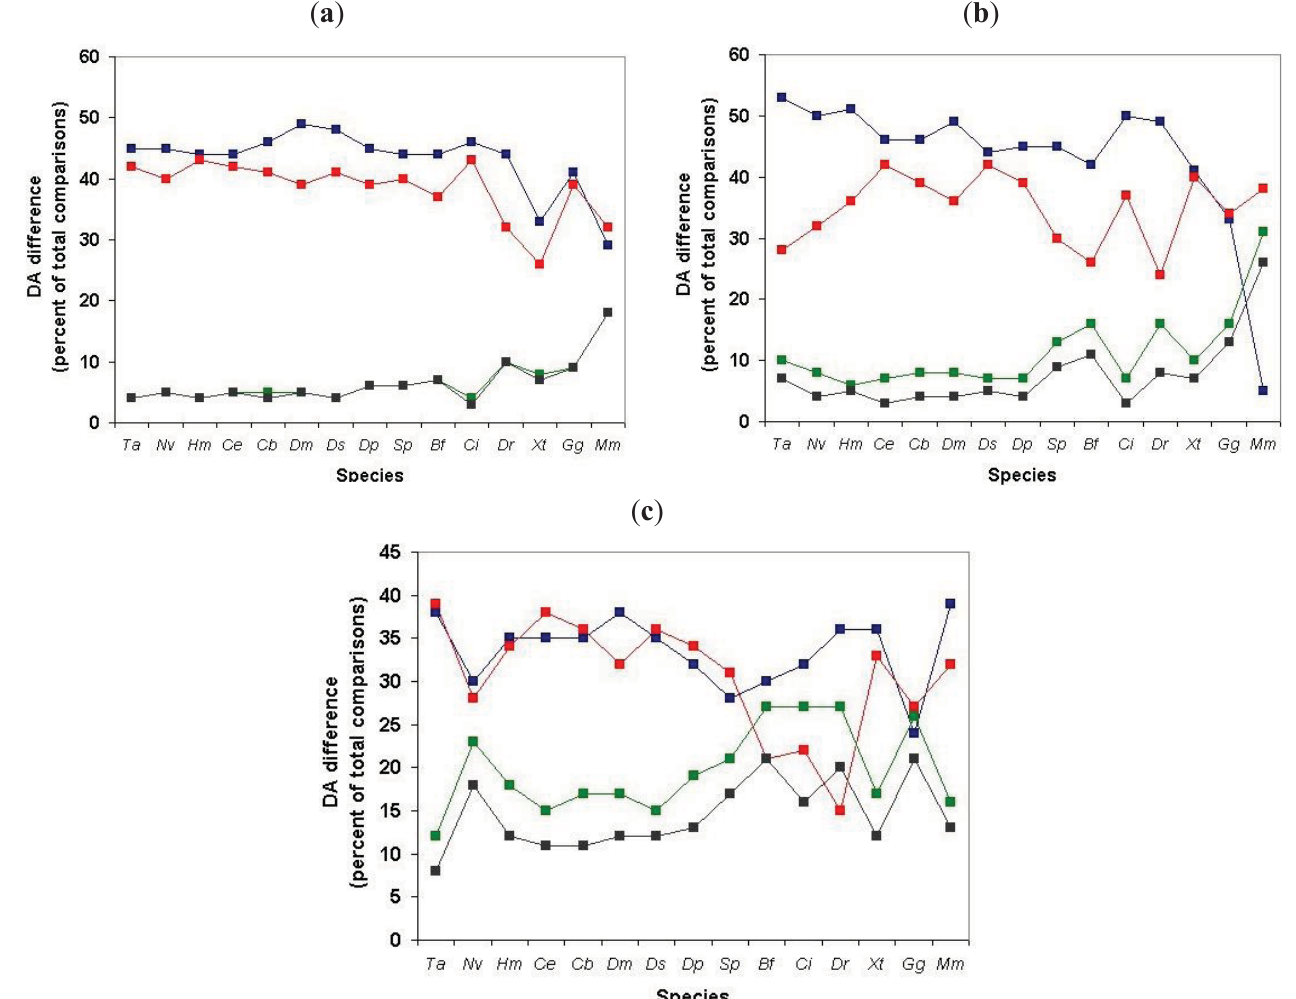
Figure 12. Analysis of the positional distribution of DA differences in clusters of human Swiss-Prot proteins defined through comparison with RefSeq proteomes of various species. The ordinate shows the proportion of pair-wise comparisons within clusters where the pairs differ in DA. N-terminal differences (blue rectangles), C-terminal differences (red rectangles), internal differences (green rectangles), tandem duplications (black rectangles). (a) Positional distribution of DA differences for type 1 transitions; (b) Positional distribution of DA differences for type 2 transitions; and (c) Positional distribution of DA differences for type 3 transitions. Note that in the case of type 3 transitions the proportion of internal DA difference is comparable to those of N-terminal or C-terminal changes only in the case of chordate species. On the abscissa the species are listed in the order of decreasing evolutionary distance from Homo sapiens , thus the abscissa has a time- dimension but their distance is not drawn to scale. Abbreviations on the abscissa: Ta - Trichoplax adhaerens, Nv - Nematostella vectensis, Hm - Hydra magnipapillata, Ce -Caenorhabditis elegans, Cb -Caenorhabditis briggsae, Dm -Drosophila melanogaster, Dp -Drosophila pseudoobscura, Ds - Drosophila simulans, Sp - Strongylocentrotus purpuratus, Bf - Branchiostoma floridae, Ci - Ciona intestinalis, Dr - Danio rerio, Xt - Xenopus tropicalis, Gg - Gallus gallus, Mm - Mus